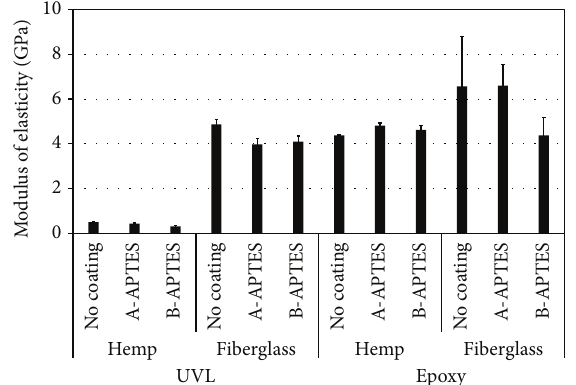
Figure 5: Effect of fiber coating on modulus of elasticity of epoxy and UVL